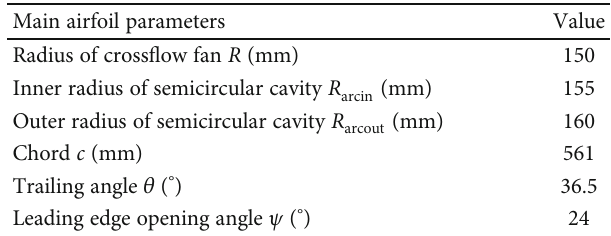
Figure 1: Fan-wing parameters. Table 1: Main parameters of Fan-wing airfoil.